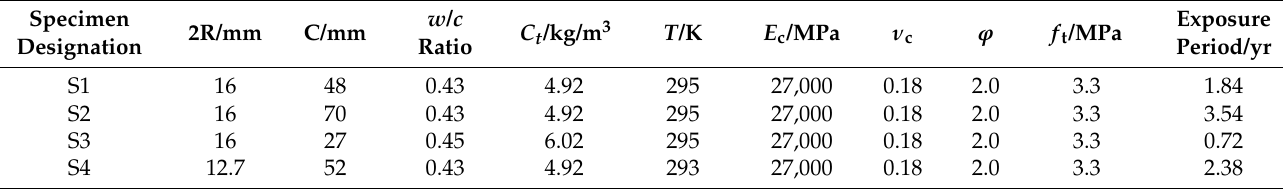
Table 1. The value of basic parameters. C t : chloride content; w/c : water–cement ratio; T : temperature; E c : elastic modulus; vc: Poisson’s ratio; f t : tensile strength.